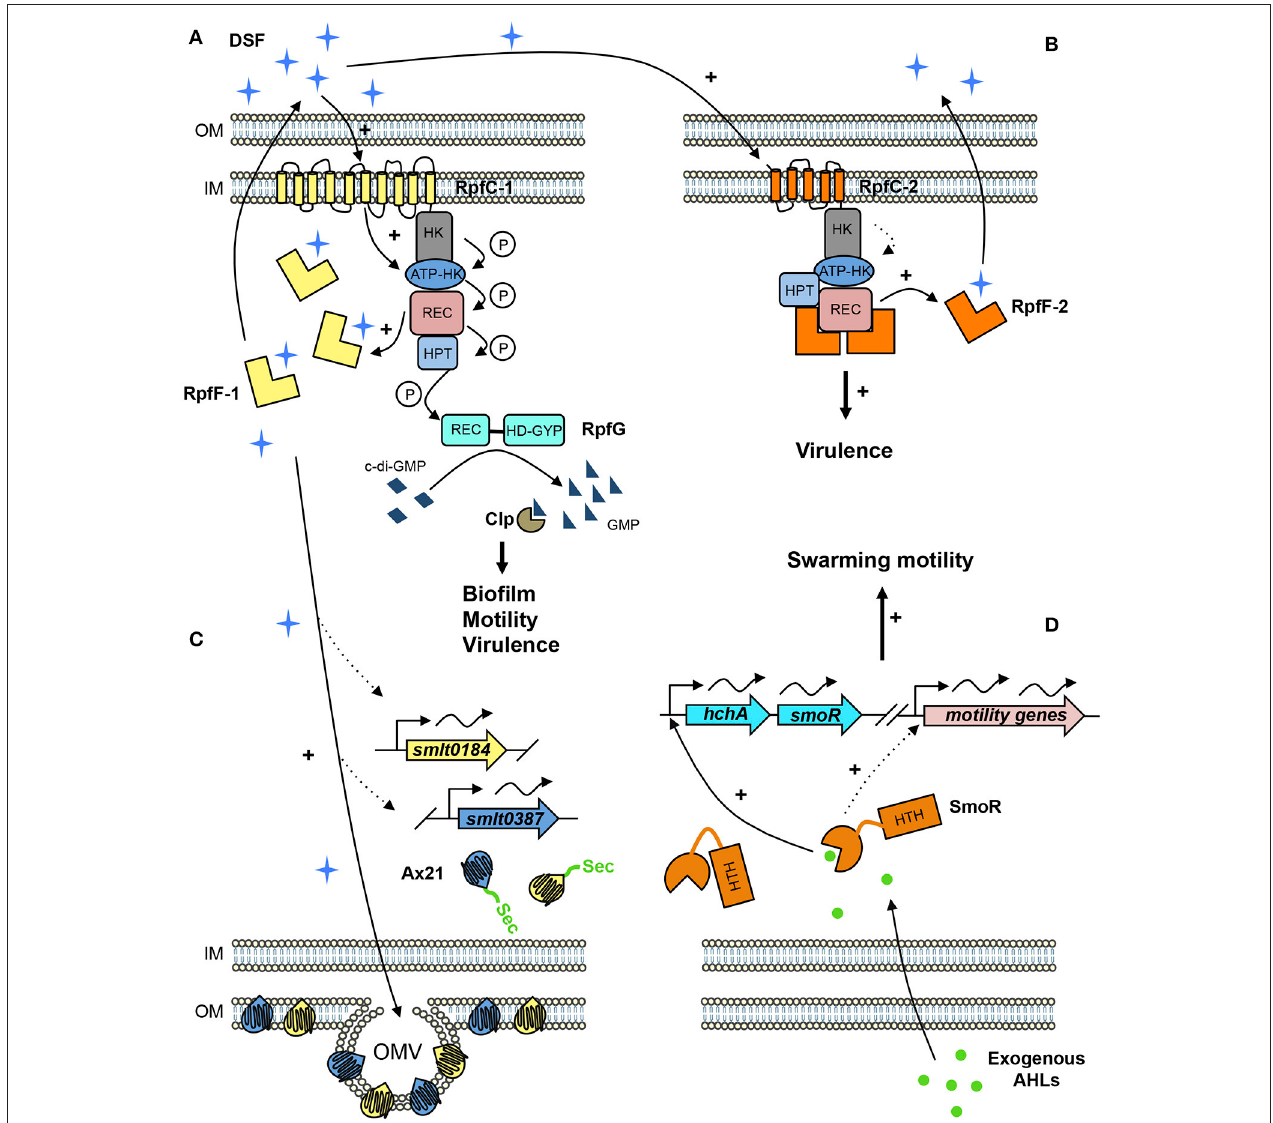
FIGURE 1 | Proposed QS signaling network in S. maltophilia . (A) In rpf -1 strains, RpfC-1 (including 10 TMR) stimulates RpfF-1 basal activity—that increases with cell density—and synthesizes DSF (cis-11-Methyl-2-dodecenoic acid) that accumulates in the extracellular environment. Once DSF concentration reaches a critical threshold, RpfC-1 senses DSF, and induces a phosphorylation cascade throughout its cytoplasmic domains ending in the response regulator RpfG, which degrades cyclic diguanylate monophosphate (c-di-GMP) to GMP activating the transcriptional regulator Clp that stimulates expression of genes involved in biofilm formation, motility, and virulence. (B) In rpf -2 strains, RpfC-2 (5 TMR) permanently represses RpfF-2, resulting in no DSF detection in axenic conditions. DSF produced by neighboring bacteria (e.g., rpf -1 strain) is sensed by RpfC-2 allowing free-active RpfF-2 and subsequent DSF synthesis. (C) DSF also stimulates the production of outer membrane vesicles (OMV) containing high amounts of the two Ax21 proteins (Smlt0184 and Smlt0387). Both Ax21 proteins present a signal peptide that is processed by the general secretory (Sec) system. (D) Exogenous AHL signals, specifically C8-HSL and oxo-C8-HSL, are sensed by the LuxR solo SmoR (Smlt1839), annotated as “LuxR chaperone HchA-associated,” activating the transcription of its own operon and promoting swarming motility. Dotted lines represent predicted or supposed interactions on the basis of reported experimental evidences. Protein domains are abbreviated as follows. HK, Histidine kinase domain; REC, Receiver domain; HPT, Histidine phosphotransferase domain; HD-GYP, Phosphodiesterase domain containing an additional GYP motif; HTH, Helix-Turn-Helix